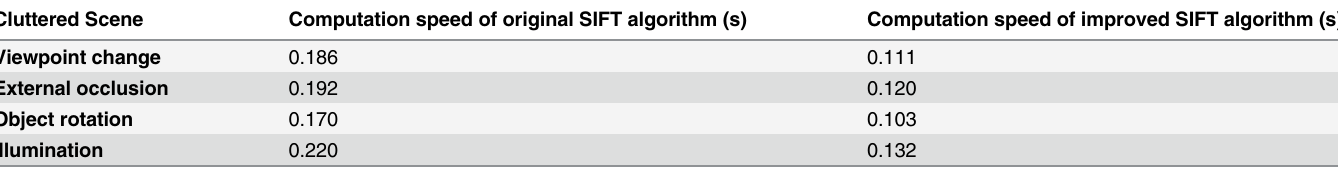
Table 3. Comparison of the computation speed for the Improved SIFT and the Original SIFT. Cluttered